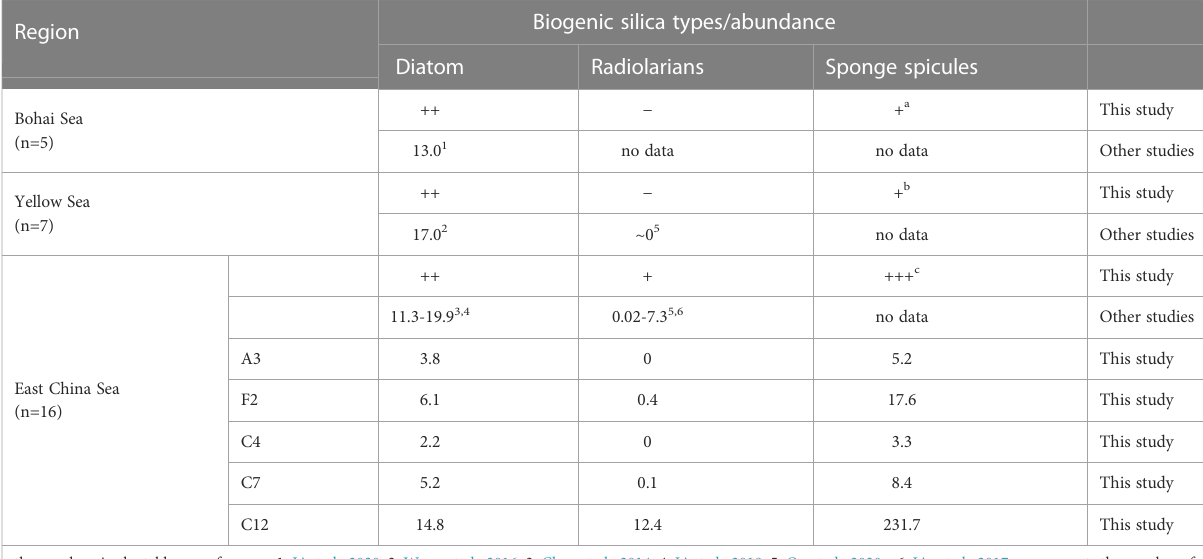
TABLE 1 Different types of marine bSi (diatoms, radiolarians, sponge spicules) and their abundances (10 3 g -1 dry sediments) in the surface sediment of East China seas.